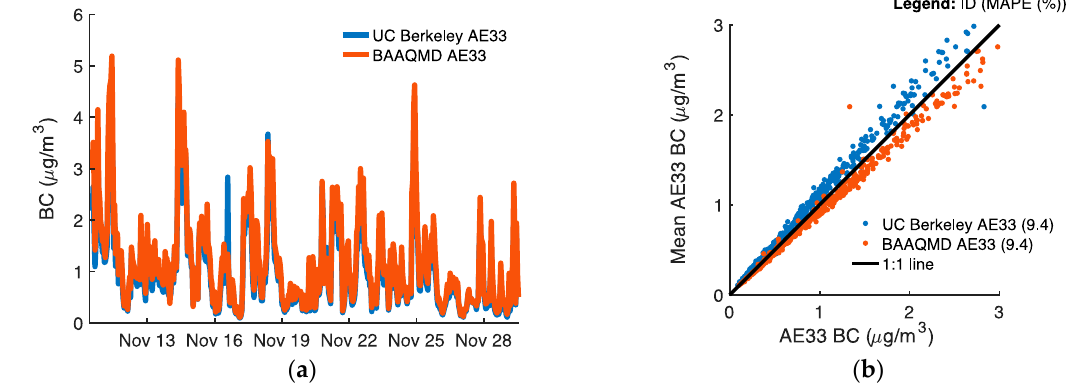
Figure A5. Two Magee Scientific AE33 instruments operating inside the Bay Area Air Quality Management District roadside monitoring station: ( a ) Time series of black carbon (BC) mass concentration measurements; ( b ) Precision of BC mass concentration measurements. All data is provided on a 60-min time base. Precision error is evaluated relative to the mean of BC measurements from both AE33 instruments, and is provided in the legend.